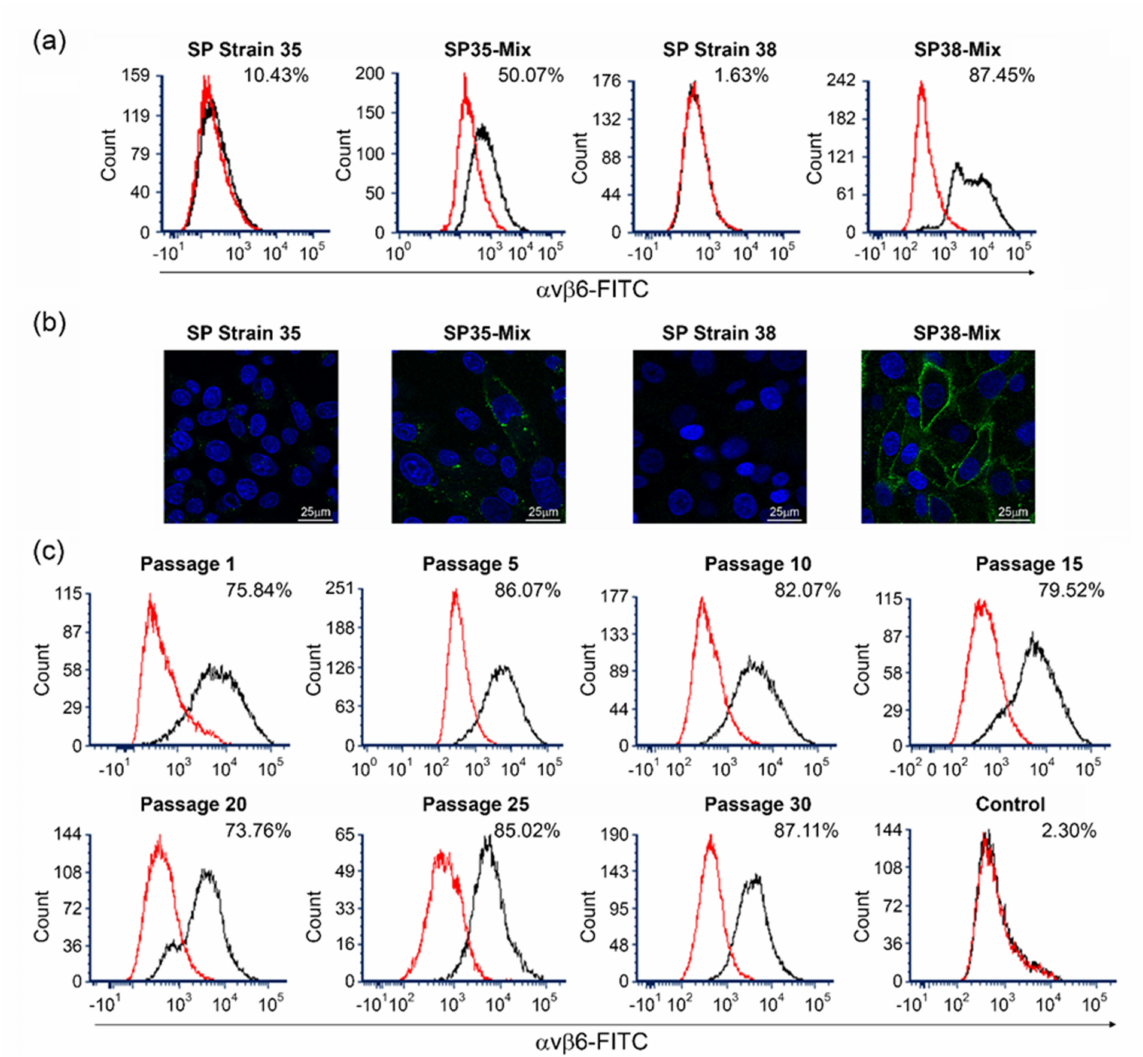
Figure 2. Analysis of α v β 6 expression in parental and recombinant cell populations. Parental SP Strain 35 and SP Strain 38, and recombinant SP35-Mix and SP38-Mix cell populations were assessed for α v β 6 expression by ( a ) flow cytometry analysis and ( b ) immunofluorescence confocal microscopy ( α v β 6 in green) using mAb clone 10D5. Nuclei are stained blue with DAPI. ( c ) To assess the stability of α v β 6 expression, SP38-Mix was consecutively passaged 30 times and flow cytometry analysis was performed every fifth passage using mAb clone 10D5. ( a , c ) The percentage (%) of positive cells expressing α v β 6 in each cell population is indicated. Cells were stained with anti- α v β 6 (clone 10D5, black) or an isotype control